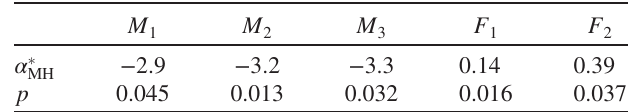
TABLE II. Strength of bias ( α (cid:2) for iCMA questions of